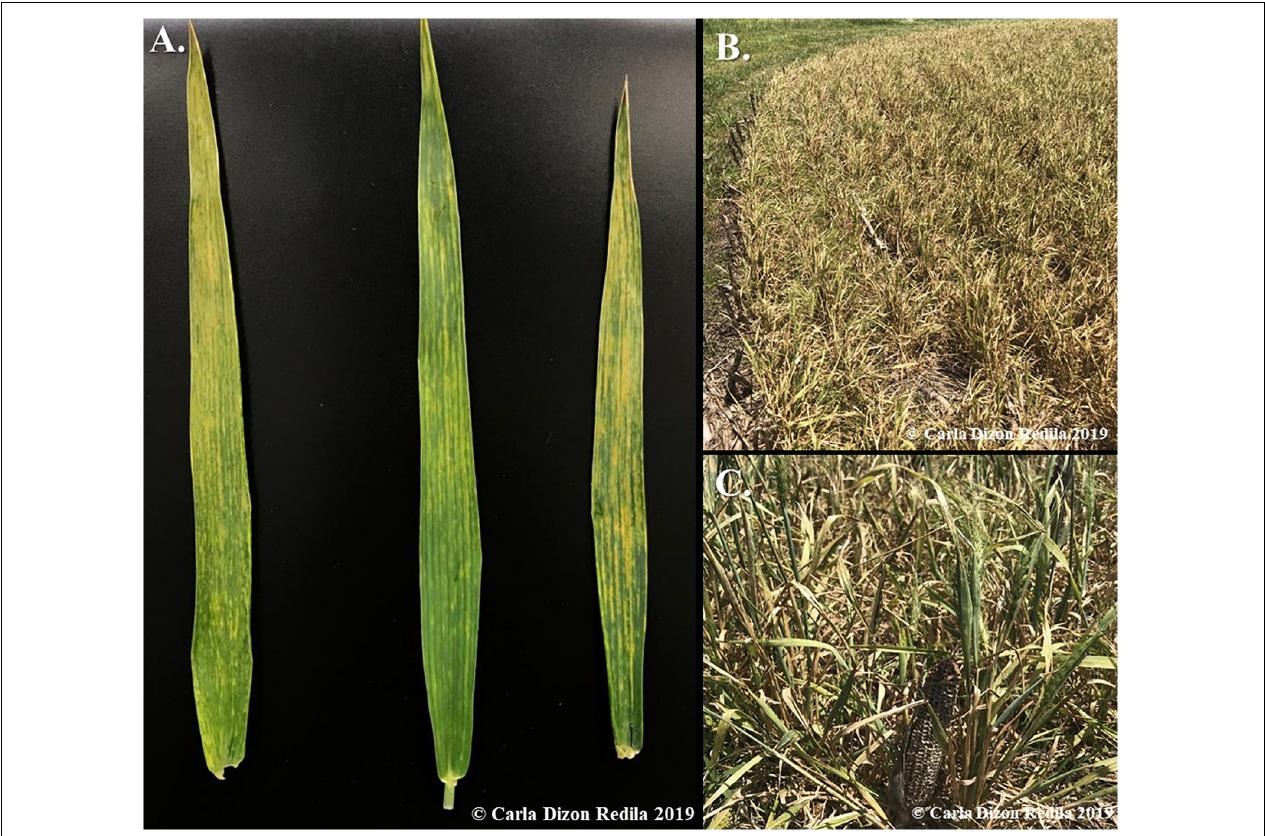
FIGURE 1 | Observed symptoms of WSM in the field. (A) Typical viral symptoms of WSM is yellow, mosaic-like streaks on leaves. (B) Severe symptoms of mixed infections of WSMV + TriMV include stunting, which leads to the underdevelopment and total loss of the crops. (C) A close-up image of the stunted wheat infected with WSM viruses, which is only twice the size of the dried corn cob used for comparison. The expected height of wheat in this ripening stage is three times